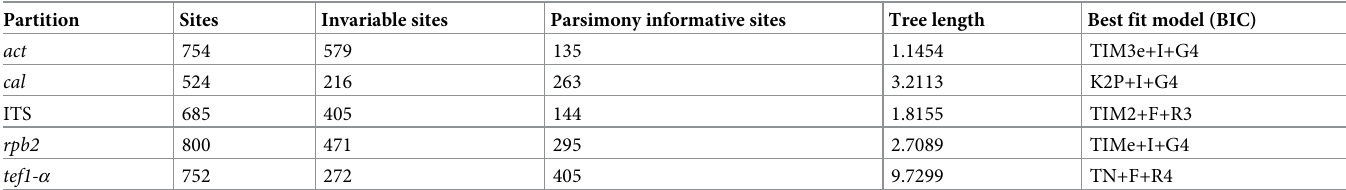
Table 4. Partition statistics for each sequenced DNA locus generated in